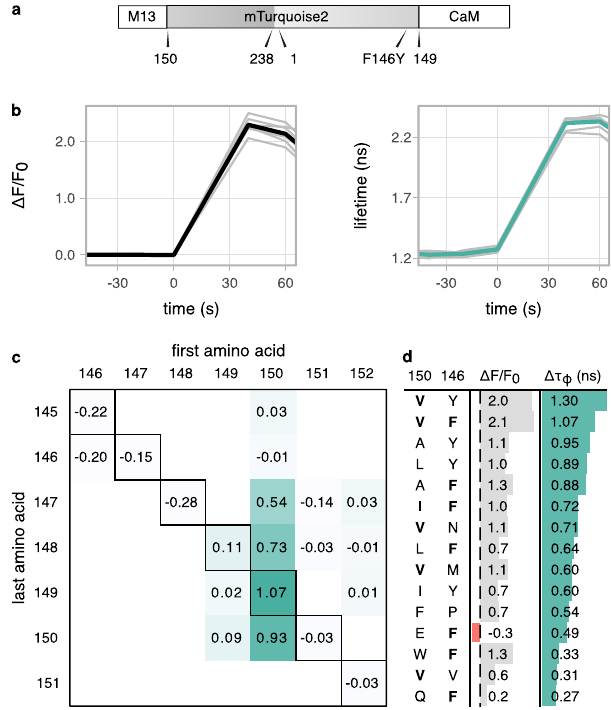
Fig. 2 Development of the Turquoise calcium sensor. a Schematic overview of the layout of Tq-Ca-FLITS, including key mutation F146Y. Positions of the original (amino acid 1 and 238) and the new (150 and 149) N and C termini are indicated. b Intensity fold-change over F 0 and phase lifetime response of Tq-Ca-FLITS.0 in HeLa cells stimulated with ionomycin and calcium at t = 0. Responses of individual cells (gray, n = 7) and their mean (black or green) are plotted. c Absolute phase lifetime change of various sensor variants in HeLa cells stimulated with ionomycin and calcium. The fi rst amino acid of mTurquoise2 after the M13 peptide and the last amino acid before the CaM are indicated. On the diagonal axis (black outline) are the sensor variants that were created to fi nd the ideal position to insert the CaM and the M13 peptide. The other variants contain two to four indels around the insertion site. Values are means of 2 – 23 individual cells. d Intensity fold-change over F 0 and absolute phase lifetime change of mutants of Tq-Ca-FLITS.0 in HeLa cells stimulated with ionomycin and calcium. Amino acids at position 150 and 146 of mTurquoise are indicated. The original residues (V and F) are printed in bold. Values are means of two to ten individual cells. Source data are provided as a Source Data fi